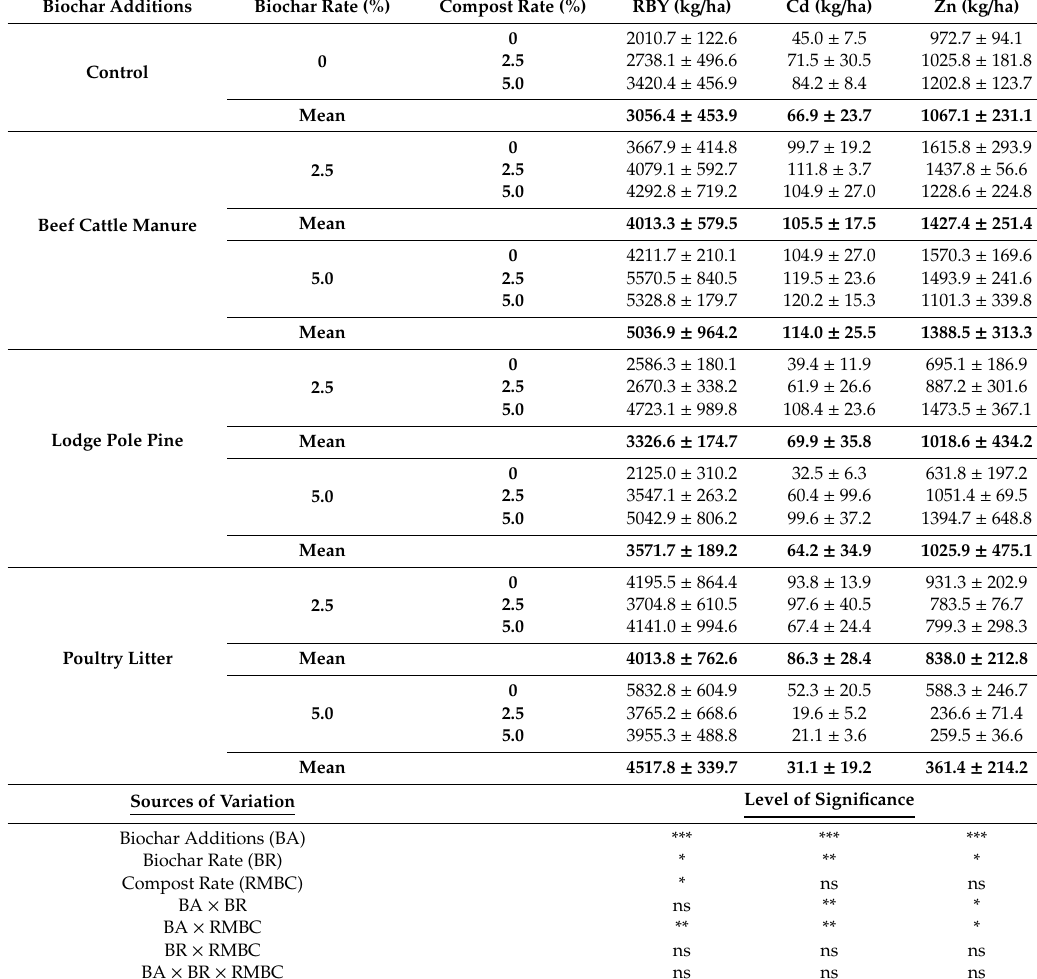
Table 6. Average roots biomass (RBY) and uptake of Cd and Zn in root biomass of